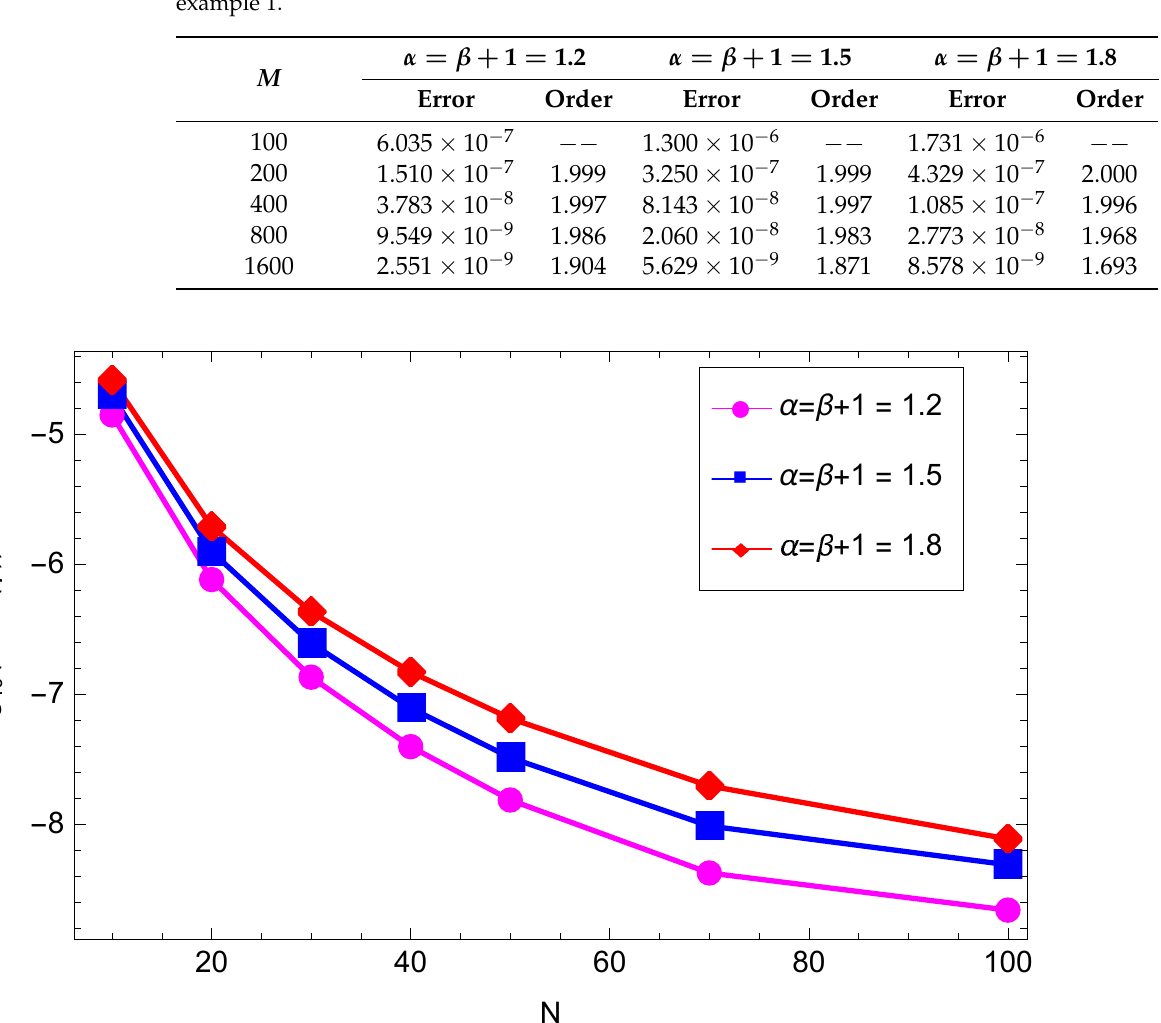
Figure 1. Convergence order of φ in space for different values of α and β at M =